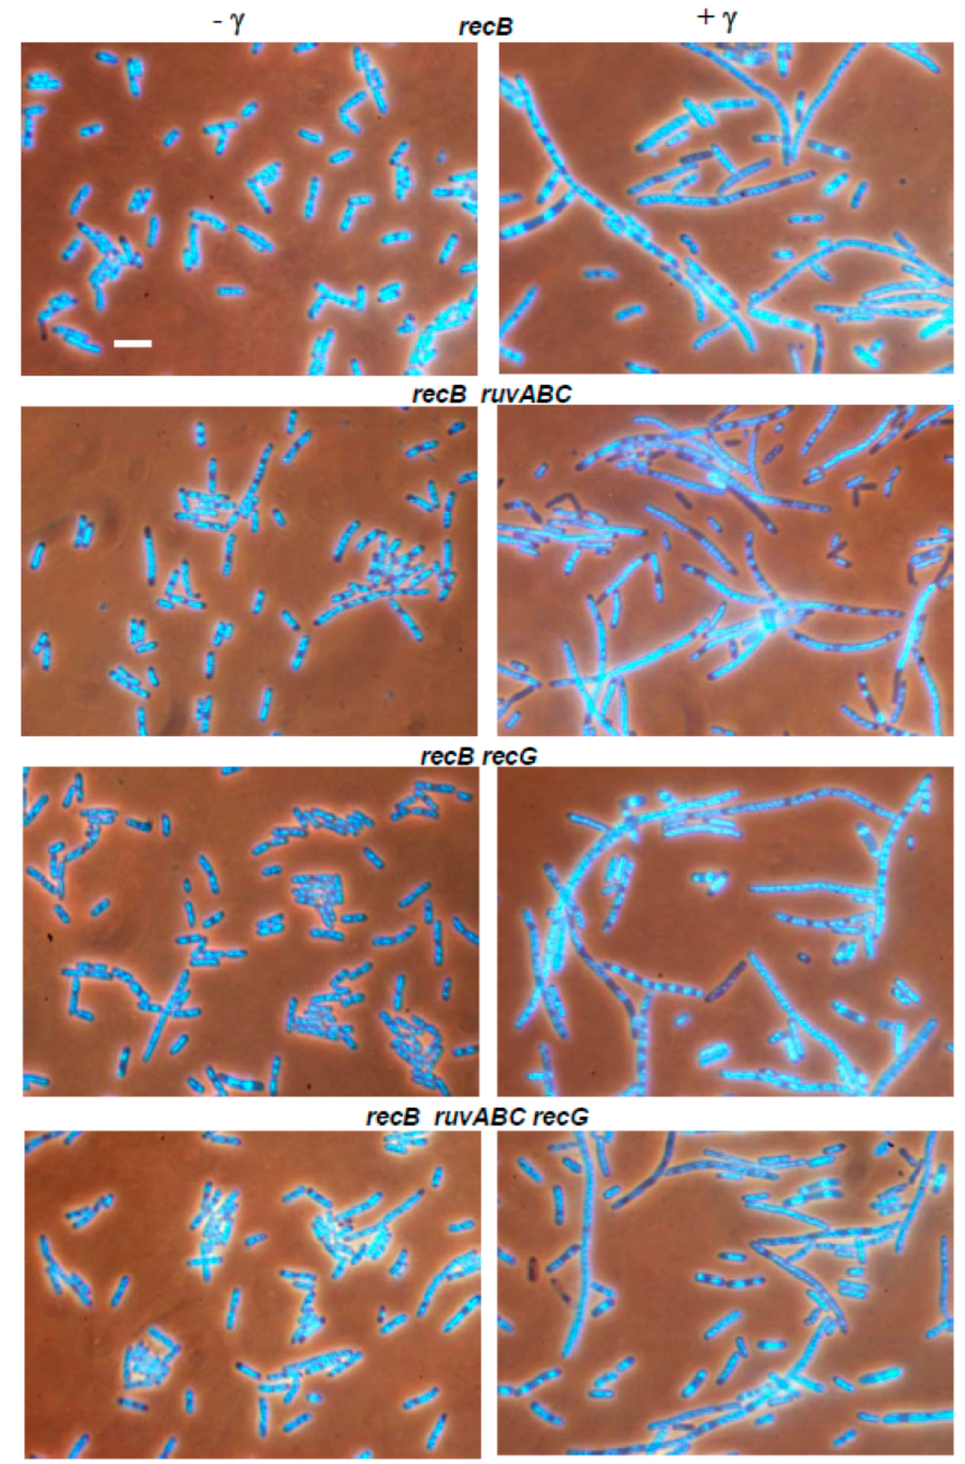
Figure 7. Suppressive effect of a recB mutation on cytological defects in γ -irradiated wild-type, ruvABC , recG and ruvABC recG strains. Bar, 5 μ m.